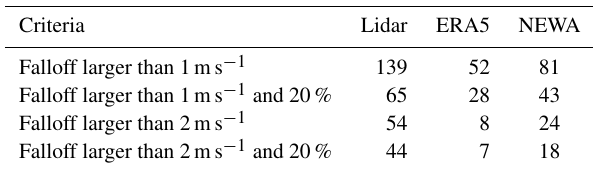
Table 2. Number of detected low-level jet events for different crite- ria (wind profiles up to